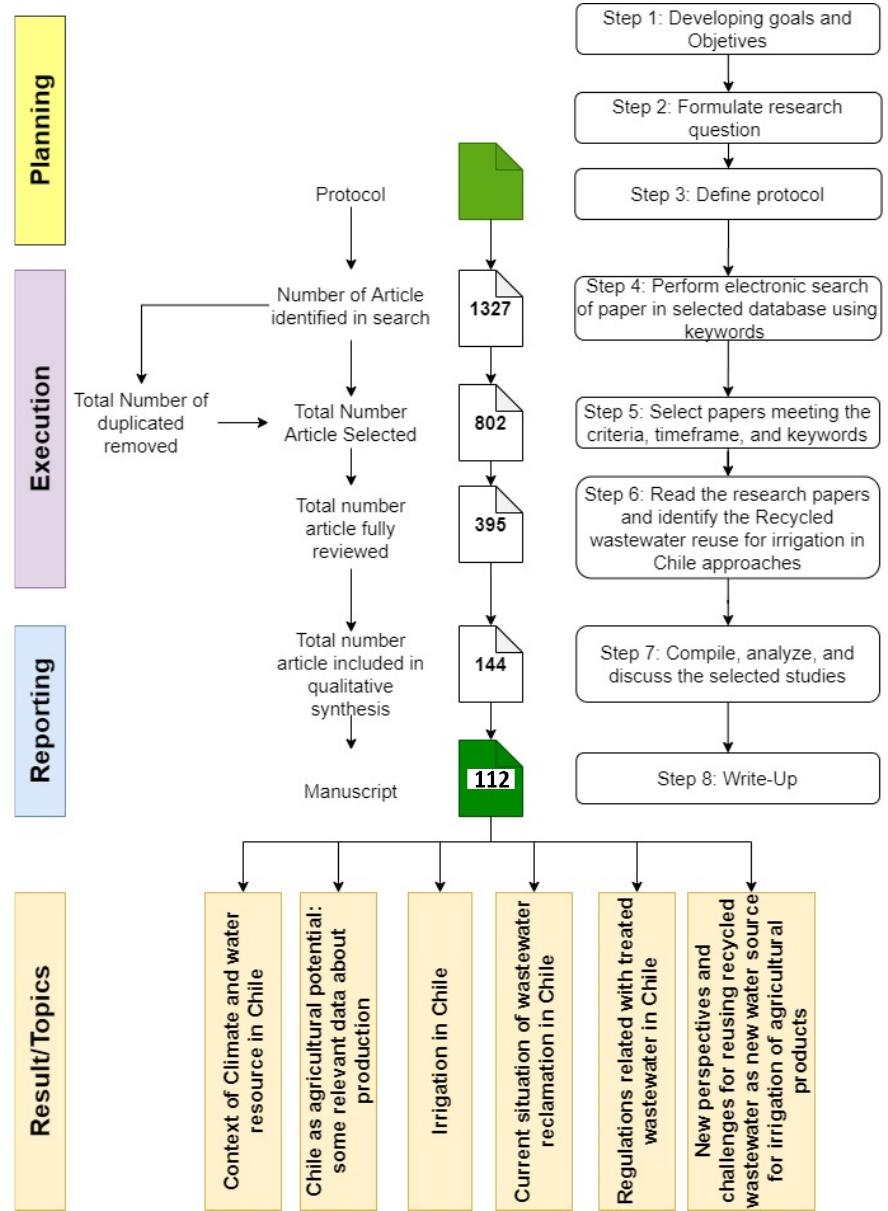
Figure 1. Information flow through the different phases of the systematic literature review (SLR). (Modified from Kim and Brown [42].).